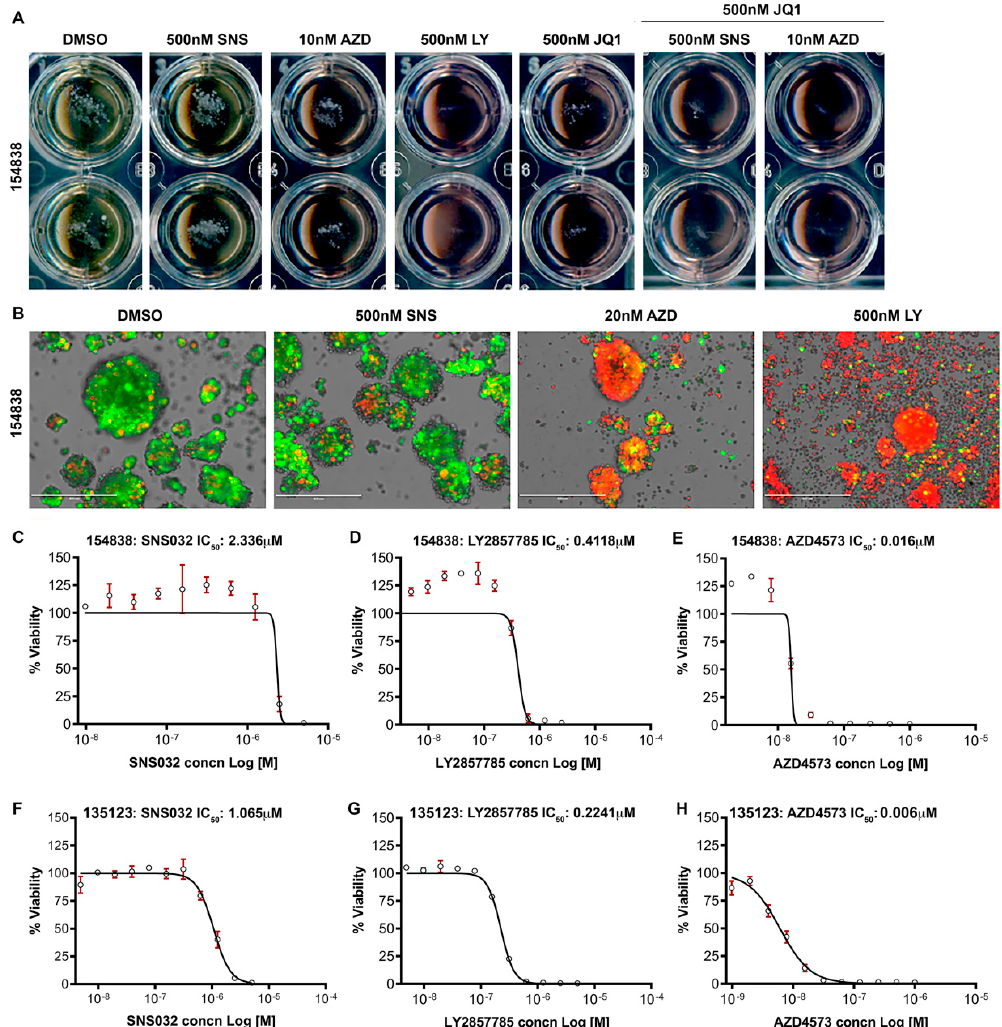
Figure 7. Lung tumor organoids treated with CDK9 inhibitors show drastic reduction in growth and induction of cell death: ( A ) lung tumor organoids (#154838) were treated with 500 nM SNS032 (SNS), 10 nM AZD4573 (AZD), 500 nM LY2857785 (LY), 500 nM JQ1, or JQ1 with SNS032 or AZD4573 for 8 days, and images were generated by scanning the organoid containing plates on a flat-bed Epson scanner. ( B ) Lung tumor organoids (#154838) were stained using the DiOC 18 green fluorescent probe and propidium iodide (PI) to determine the survival status of cells within the remaining organoid spheres after the CDK9 inhibitor treatment. Green fluorescence is indicative of live cells and PI positivity (red) is indicative of compromised cell membrane and cell death. ( C – H ) IC 50 analysis was conducted on two different lung tumor organoids, #154838 ( C – E ) and #135123 ( F – H ), with 10 different concentrations of SNS032, LY2857785, or AZD4573 for 96 h, using the GraphPad Prism software.